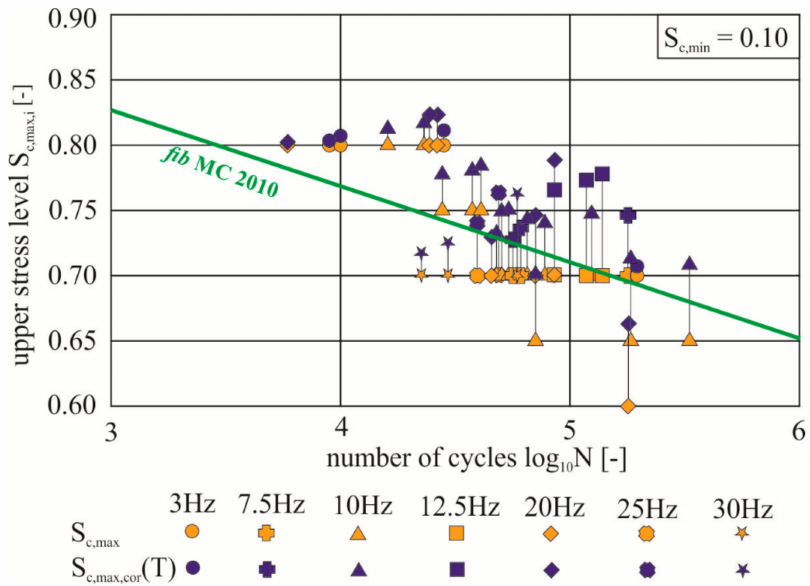
Figure 9. Achieved number of load cycles with initial maximum stress as well as the corrected maximum stress level according to Equations (4) and (5) at different frequencies from 3 to 30 Hz and S c,min =